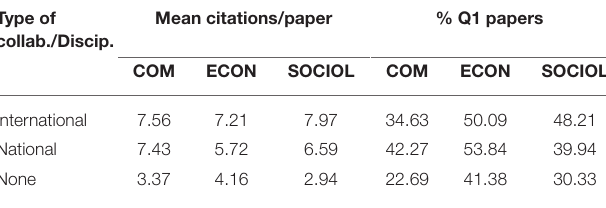
TABLE 4 | Impact and visibility by type of collaboration and discipline. Type of collab./Discip.